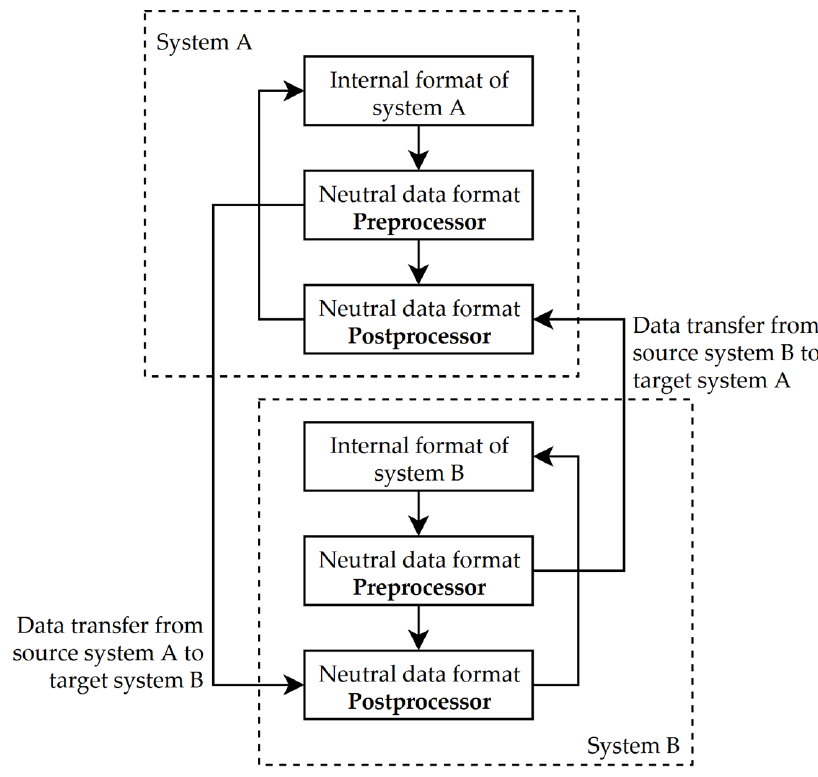
Figure 1. Process flow of neutral file-based data exchange.